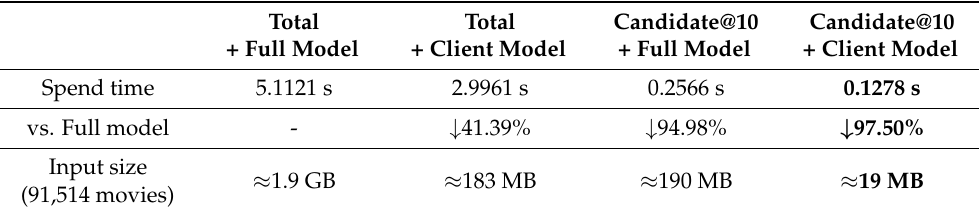
Table 4. Speed test by scenario. From left to right, full movie inference scenario using MovieDI- Rec+ full model. Full movie inference scenario using only the client model of MovieDIRec+. Top 10 candidate movie inference scenarios in full model. Top 10 candidate inference scenarios in client model. As for the input size, there is a slight difference between input vectors for each movie, so the approximation is expressed through ≈